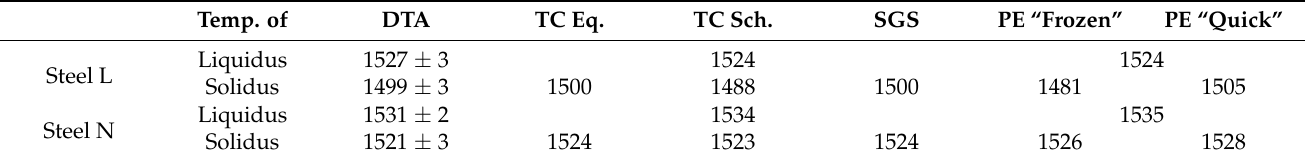
Table 2. Liquidus and solidus temperatures (in ◦ C) measured by DTA and calculated with Ther- moCalc (equilibrium, 99% solidified: “TC. Eq.”) and Scheil–Gulliver with back-diffusion and back- transformation (”TC Sch.”, 95% solidified) and SGS model [13] compared with the present algorithm with “frozen” and fast diffusion of metal elements in ferrite.